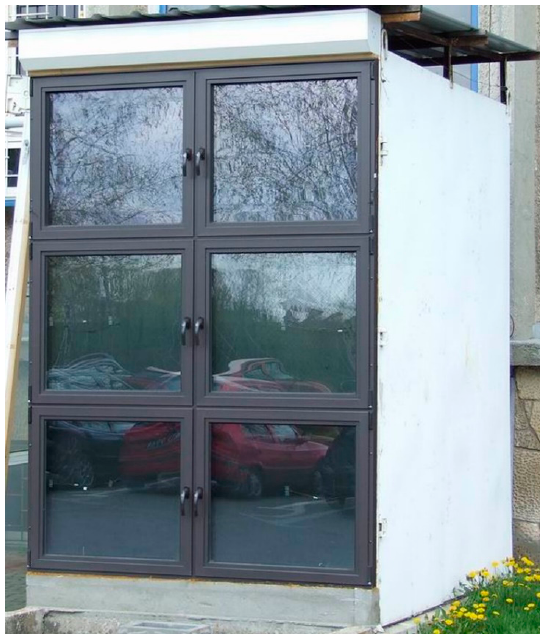
Figure 1. View of the test chamber after completing the